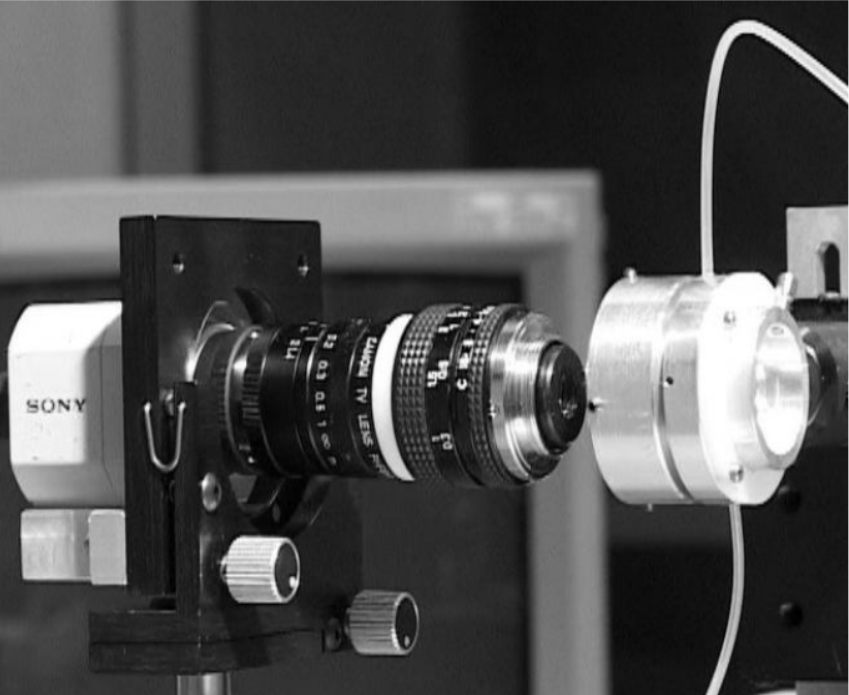
Figure 11. Photograph of the device used by Gobbi et al. In the experimental setup, the fully assembled eye model is on the right side of a camera objective. A cornea lens can be easily seen attached on the right surface of the cylindrical model. Proceedings of the Ophthalmic Technologies XIII; SPIE, Bellingham, WA, 2003; Volume 4951, p. 104 ([97]). Originally published by and reprinted with permission from Gobbi, P.G.; Fasce, F.; Bozza, S.; Brancato, and